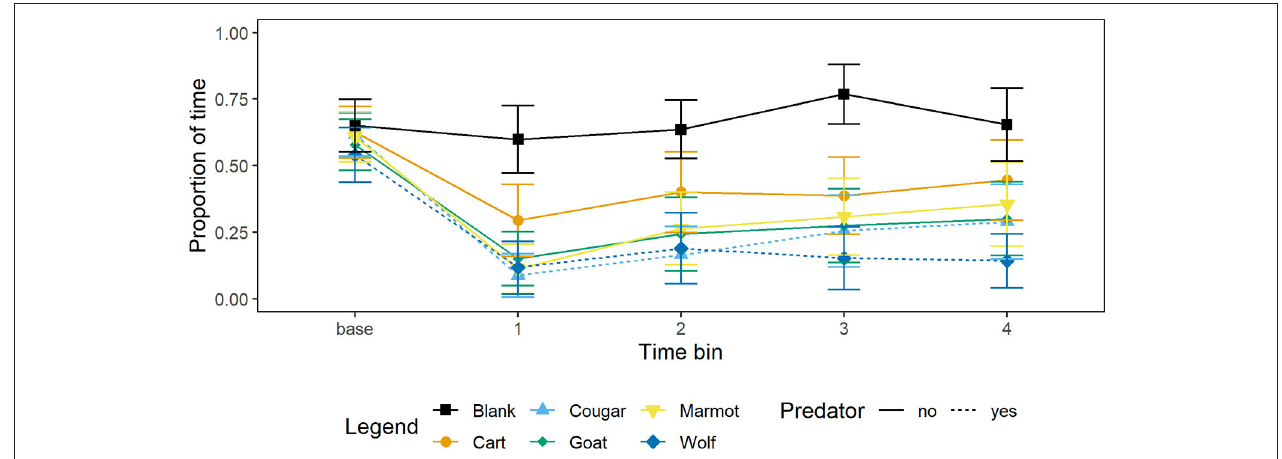
FIGURE 1 | Mean proportion of time and 95% CI per 15s time bin that marmots ( n = 34) spent foraging when presented with each of four mammal taxidermy mounts, a cart, and when a blank was scored. Baseline value represents proportion of 60s prior to the stimulus being presented that marmots allocated to foraging.